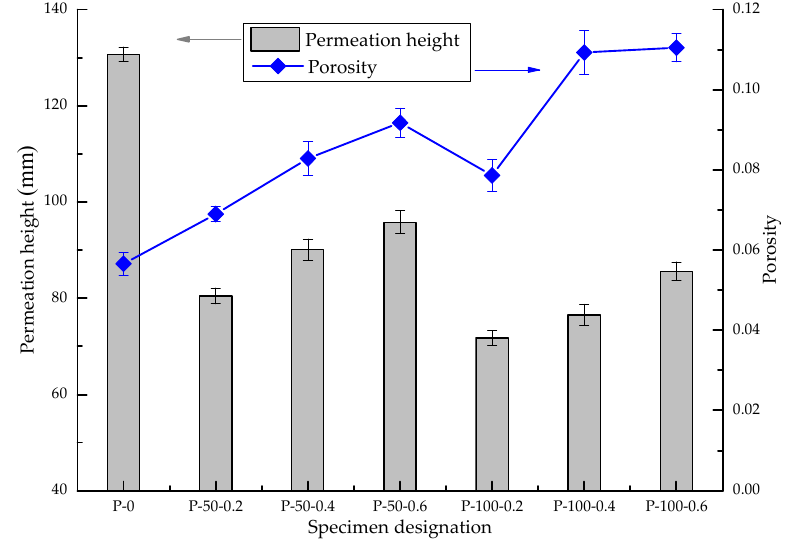
Figure 7. Relationship between permeation height and porosity.